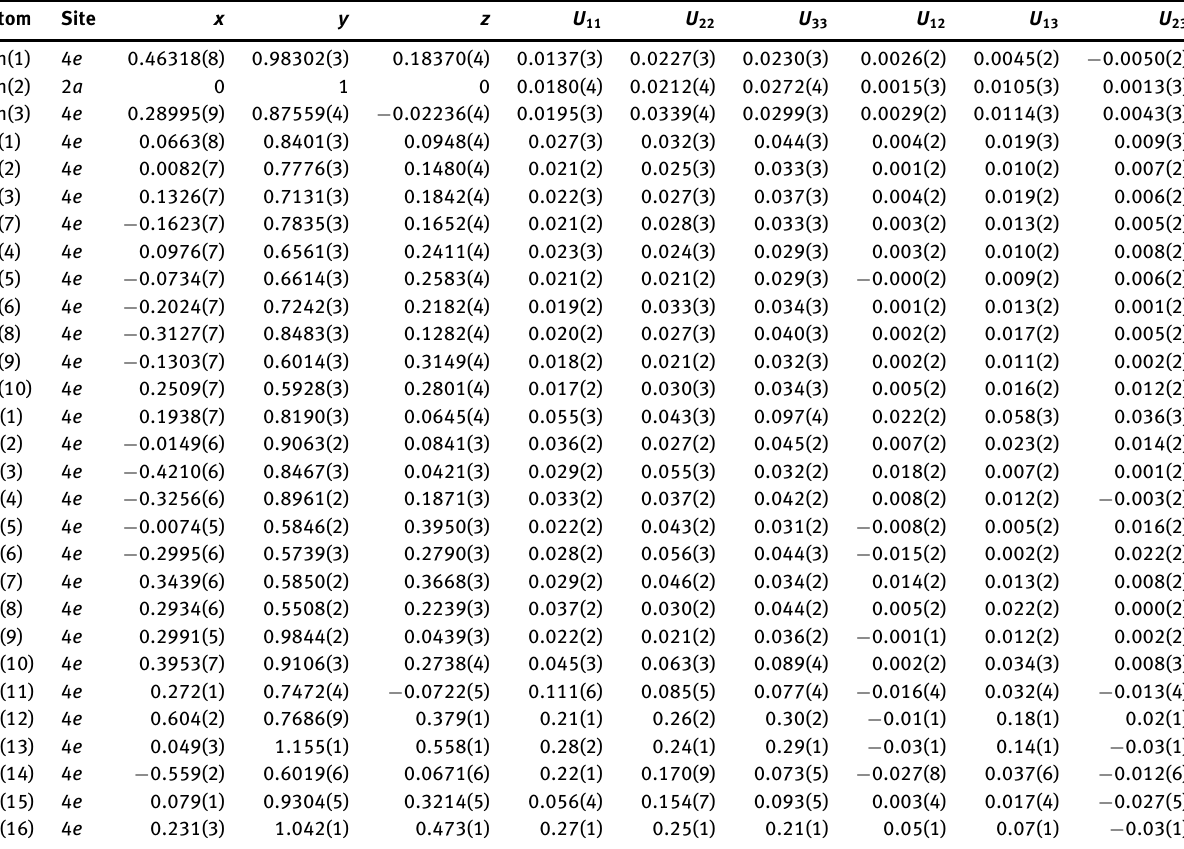
Table 3: Fractional coordinates and atomic displacement parameters (Å 2